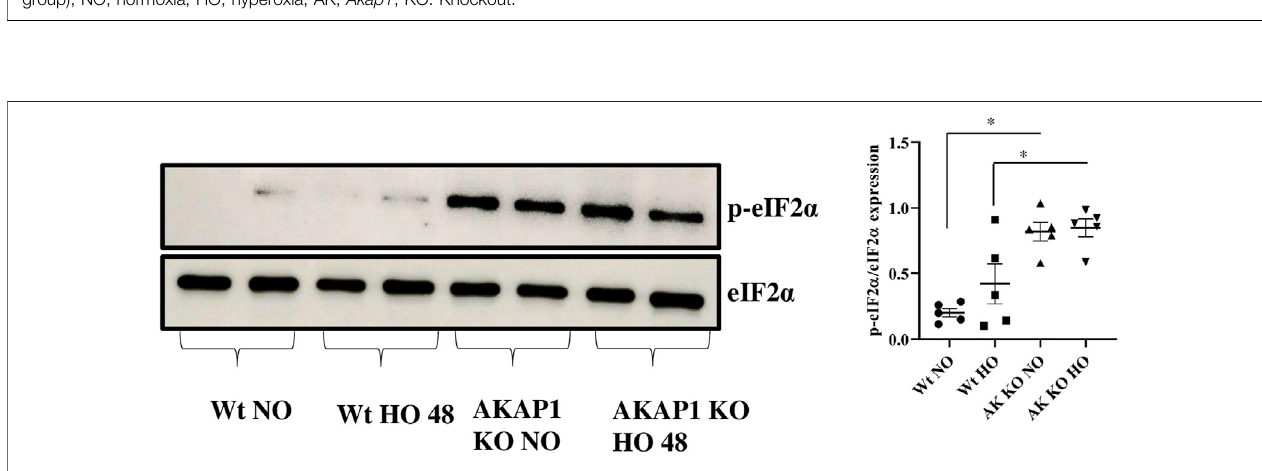
Frontiers in Pharmacology |